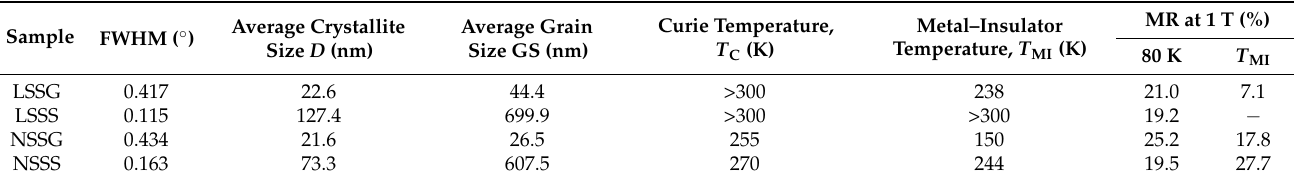
Table 2. FWHM, crystallite size, grain size, T C , T MI , and magnetoresistance (MR) at 1 T for LSMO and NSMO samples.